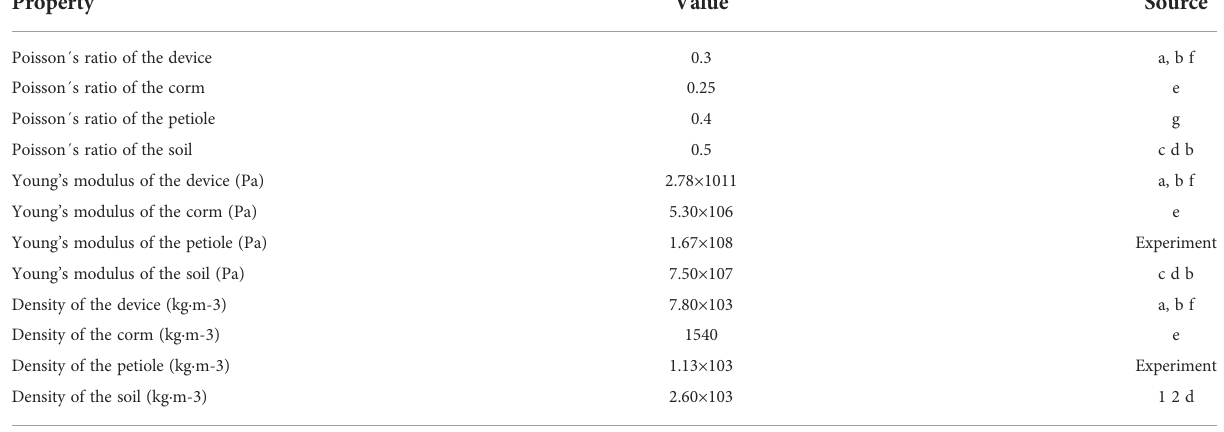
in Table 1. The contact parameters (coef fi cient of restitution, coef fi cient of static friction and coef fi cient of rolling friction) of taro corm and petiole were obtained through tribometer experiment and high-speed photographic experiment in the TABLE 1 Intrinsic parameters.